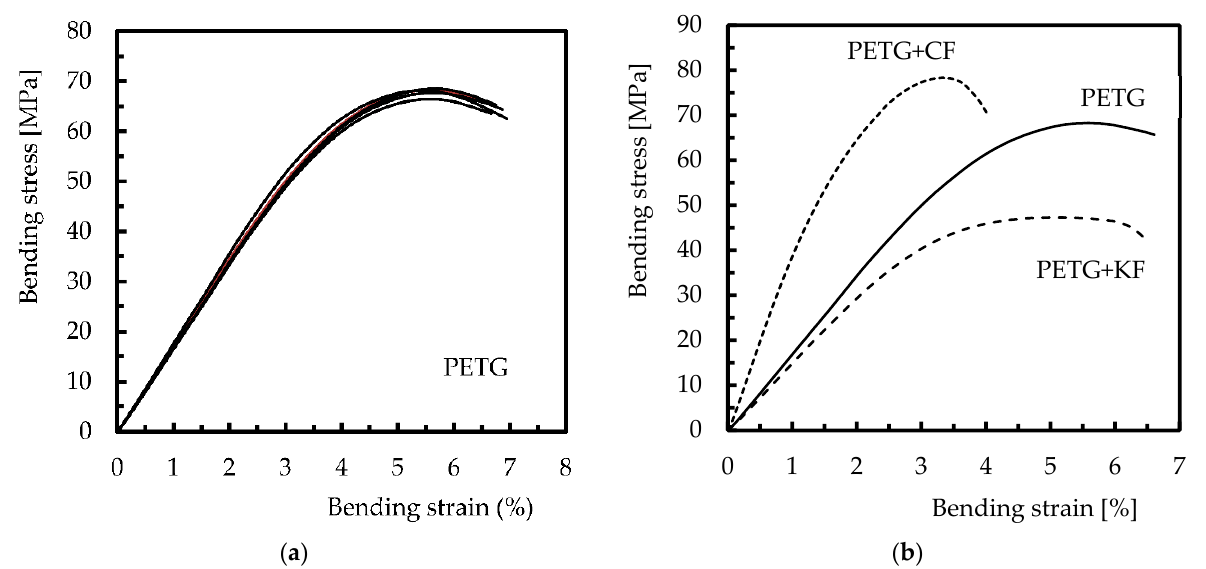
Figure 9. Bending stress–strain curves showing the: ( a ) repeatability of the curves for neat PETG; ( b ) comparison between materials. Table 13. Results of the thermal analysis for PETG, PETG+CF and PETG+KF.